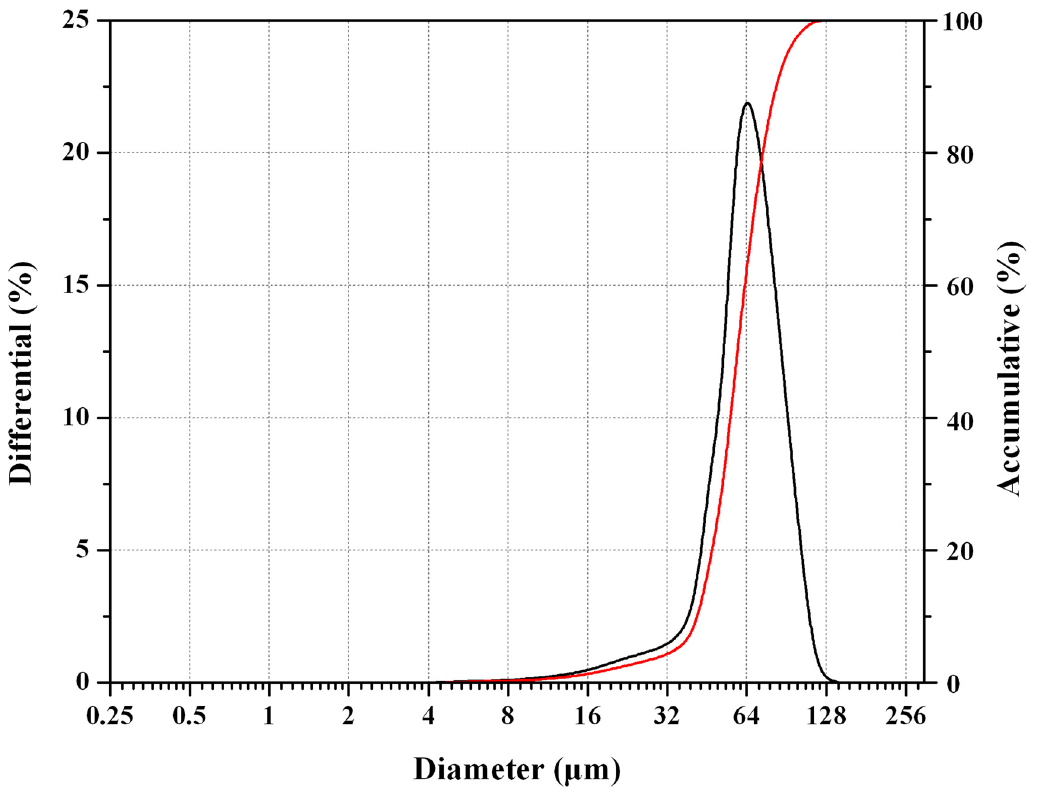
Fig 2. Particle size distribution of nalmefene loaded PLGA